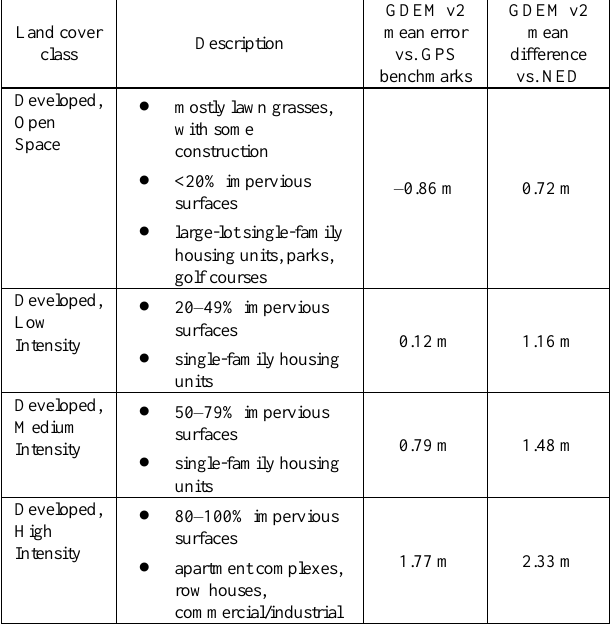
Table 2. Increasing GDEM v2 mean error with increasing density of developed land